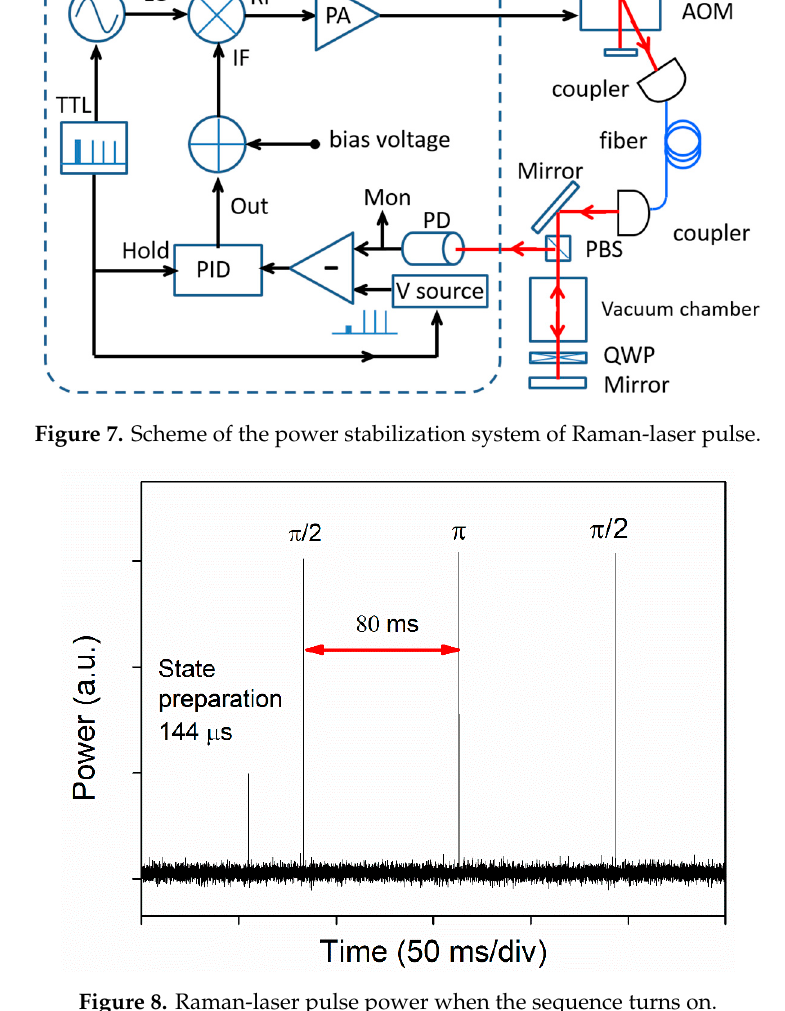
Figure 8. Raman-laser pulse power when the sequence turns on.